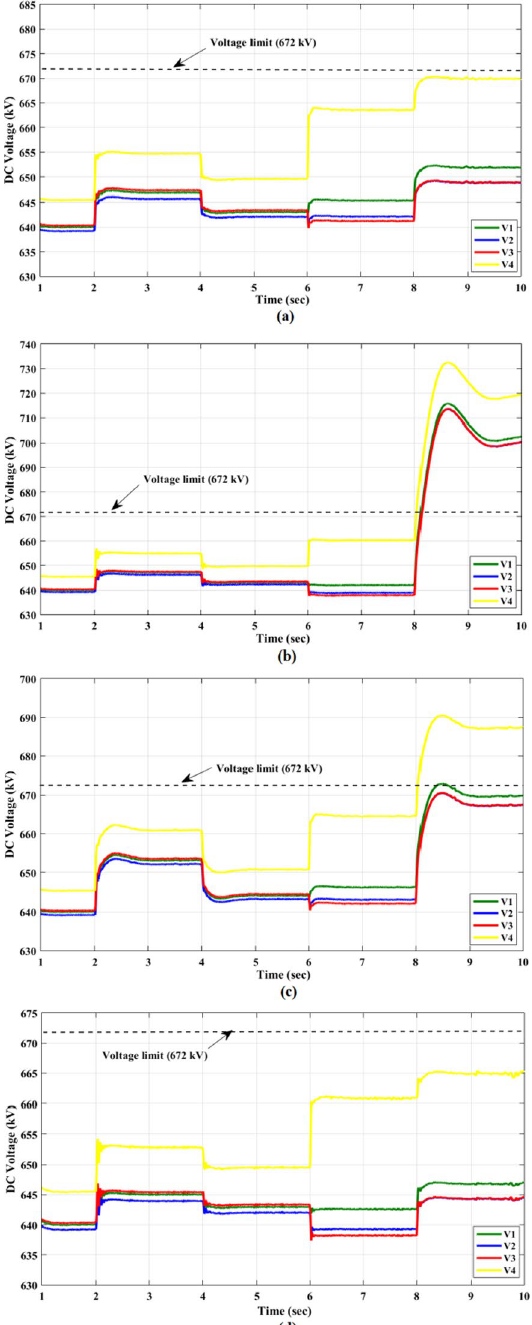
Fig. 6 DC voltages of VSC stations in different control methods: a fixed droop control. b P-based adaptive droop control. c P–V-based adaptive droop control. d proposed adaptive droop control